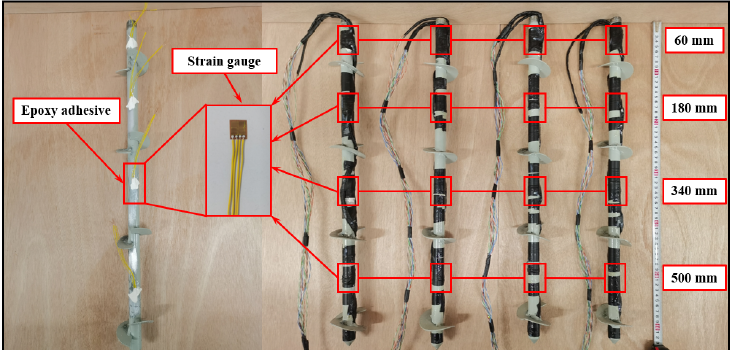
Figure 2. Preparation of small-scale pressure-grouted helical piles with strain gauges.